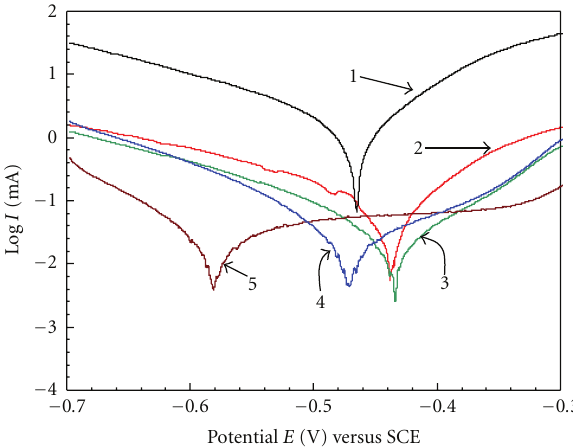
Figure 3: Anodic and cathodic polarization curves of carbon steel in an uninhibited 1.0M HCl solution and in 1.0M HCl containing various concentrations of the aqueous extract of Neem